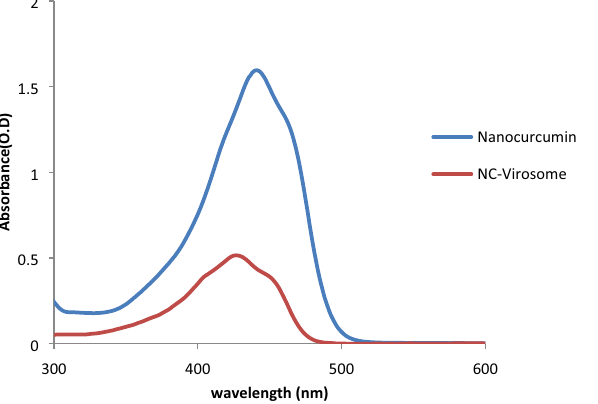
Figure 1. UV–visible spectrum showing a characteristic peak of nanocurcumin at 435 nm and a shifted peak at 419 nm for